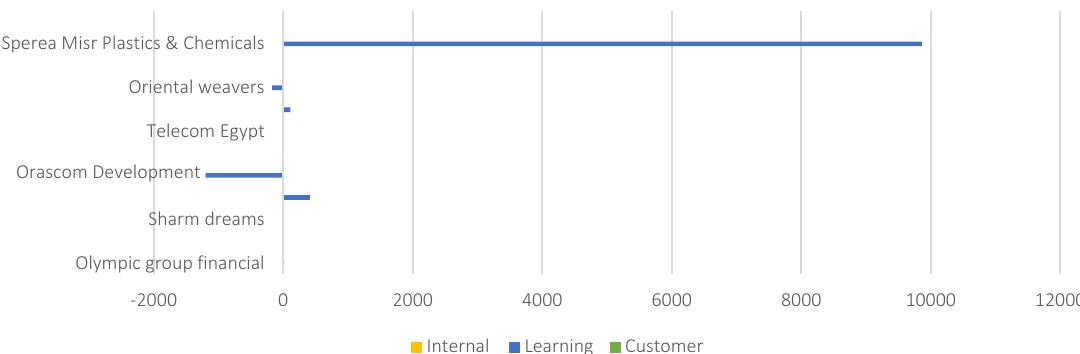
Figure 2. Non-financial perspective across the